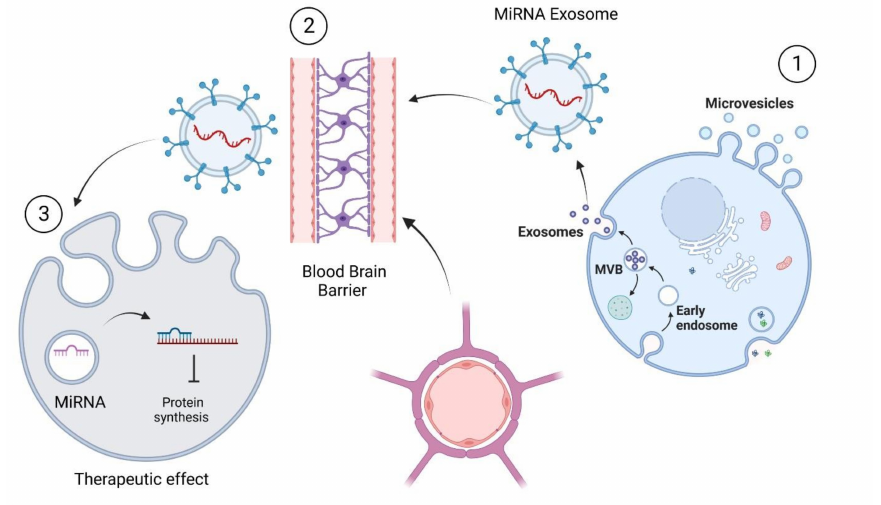
Figure 4. The ability of sEVs’ miRNAs to cross the blood-brain barrier presents an opportunity to correct endogenous miRNAs’ levels through miRNAs/anti-miRNAs treatment (created with BioRender.com) (accessed on 13 January